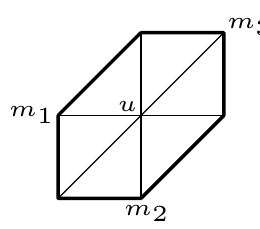
Figure 3 . Toric diagram for the sunset